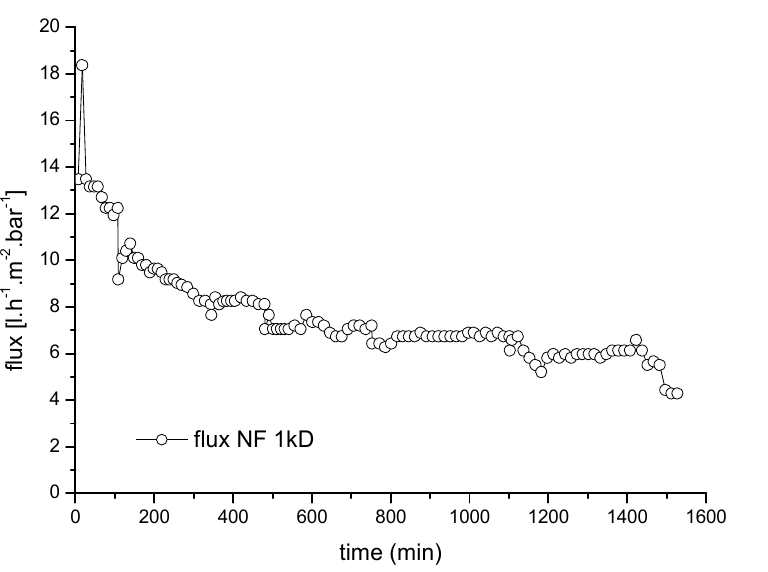
Figure 10. Average permeability of a 20-kDa ceramic UF membrane in semi-batch mode with and without back flushing during the filtration of bleaching effluent. Temperature = 60 °C; back flushing duration 2–10 s every 15 min at 4 bar (AP = average permeability).